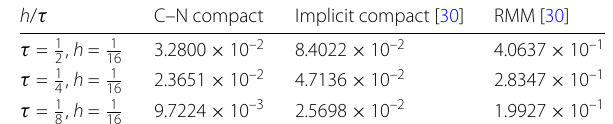
Figure 1 The convergence of the proposed method compared with the implicit method and RMM for Test problem